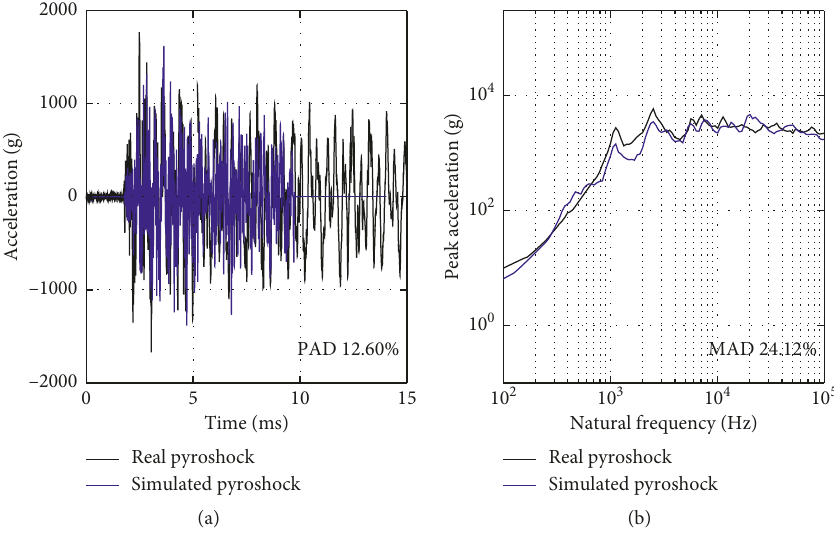
Figure 11: Simulation results of 1/2 inch pyrolock-induced shock at the verification point. Table 4: Comparison of the peak-to-peak acceleration between the explosive bolt and the